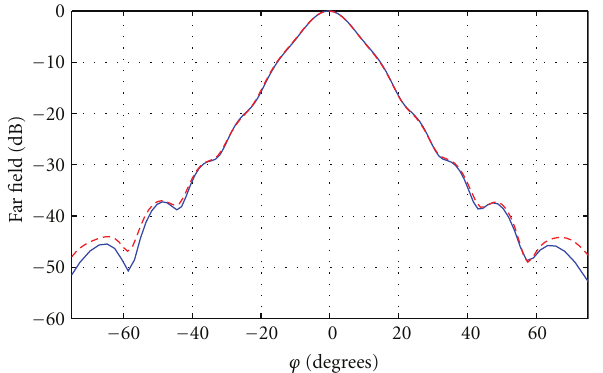
Figure 6: Single horn . ϑ cut of the ϑ component of the far field. Blue solid line: proposed approach. Red dashed line: approach in [6].